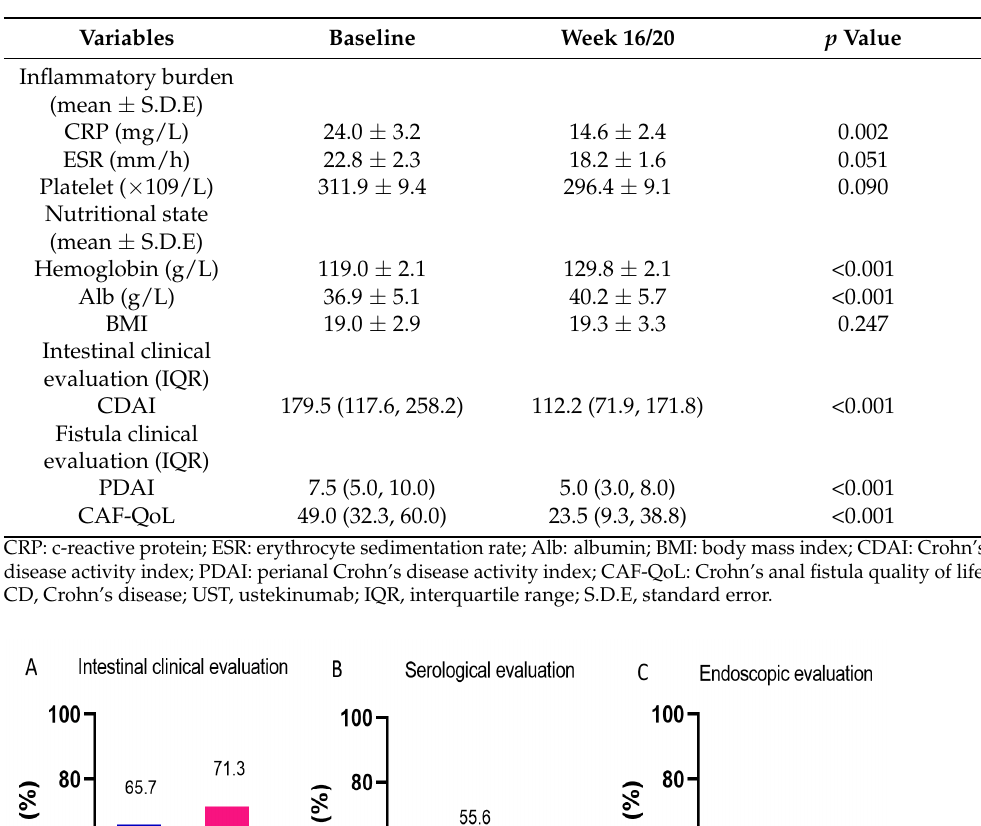
Table 2. Efficacy of UST on patients with perianal fistulizing CD ( n = 108).